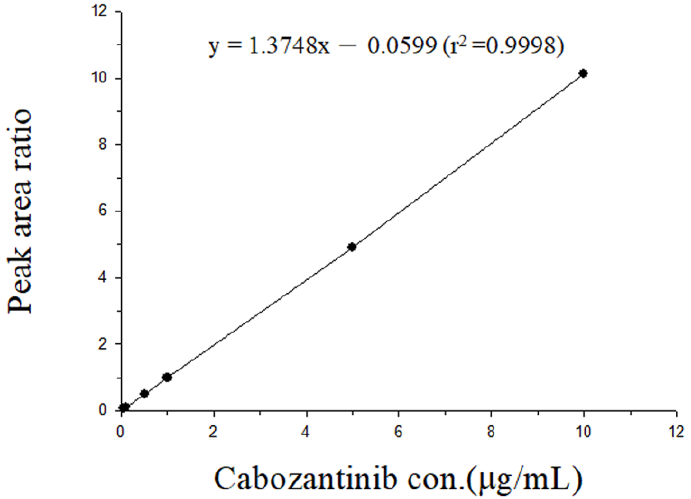
Figure 1. Calibration curve for cabozantinib in the range of 0.05 – 10 µg/mL. The T 1/2 and MRT decreased by 58.8% ( p = 0.01) and 57.8% ( p = 0.01) in the RT 9Gy × 3 f’x